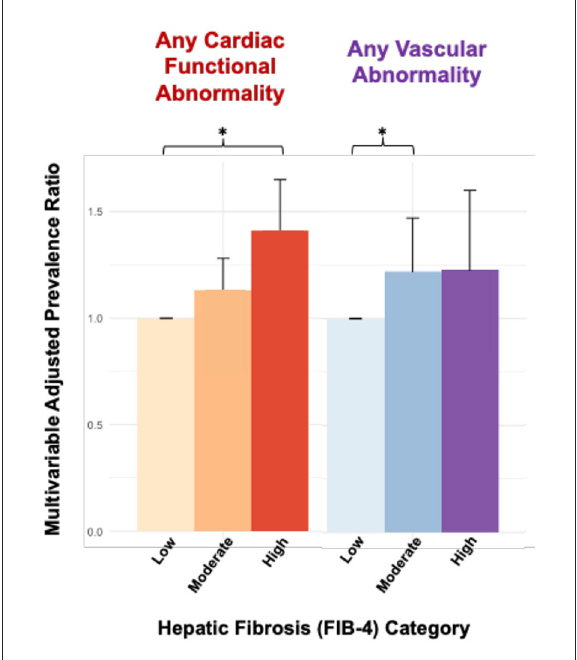
FIGURE1 Cardiac MRI abnormalities associated with hepatic fibrosis by FIB-4. Bars are organized by FIB-4 score in ascending order (low, moderate, high) within each group . * p < 0.05, FIB-4 level low was used as